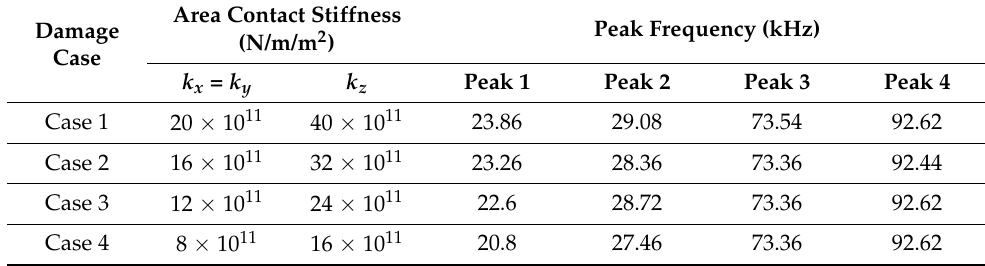
Table 4. The peak frequency vs. damage case.